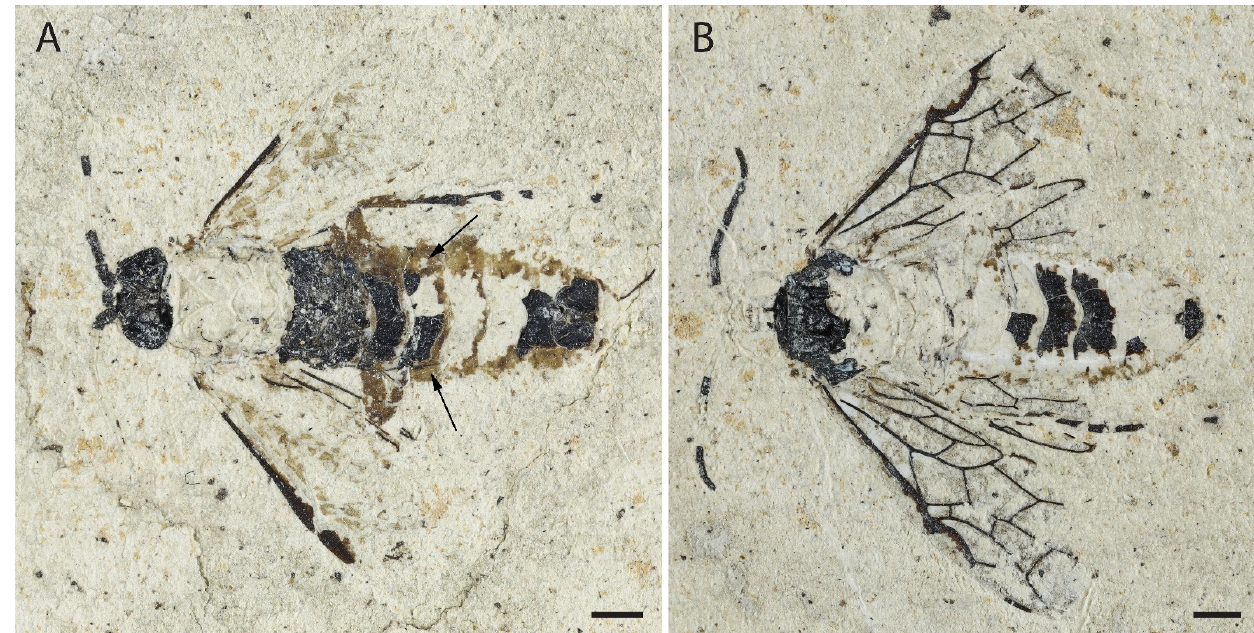
Figure 4. Empria sammuti sp. nov., holotype IGR-PAL-2860. Photographs of habitus. ( A ) Imprint, arrows show less-sclerotized zones. ( B ) Counterimprint. Scale bars = 1 mm.